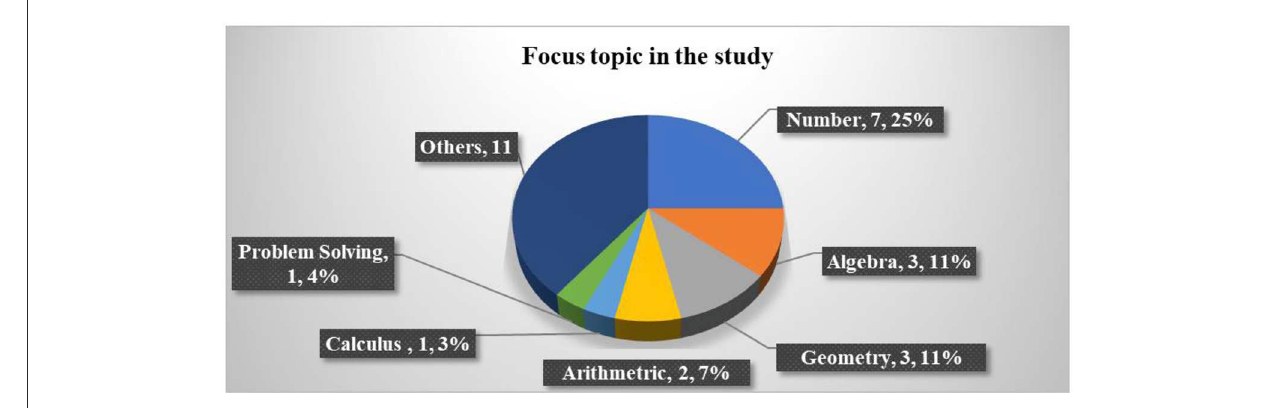
FIGURE6 The number of articles based on the topic studied.